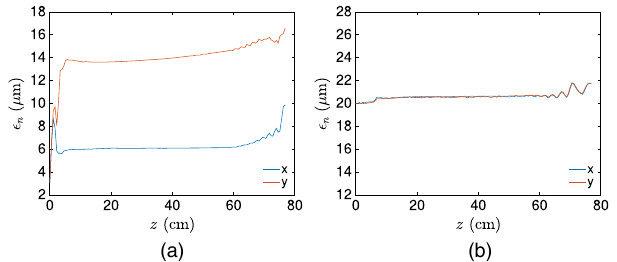
FIG. 8. The evolution of normalized emittance of the witness beam: (a) We use the same parameters as we used in the preformed plasma simulation in the previous section: Drive beam: ϵ n ¼ 3 . 4 μ m, ϵ n ¼ 3 . 0 μ m, witness beam: ϵ n x y 3 . 15 μ m. (b) We increase the initial emittance for both beams to 20 μ m (in both x and y directions).